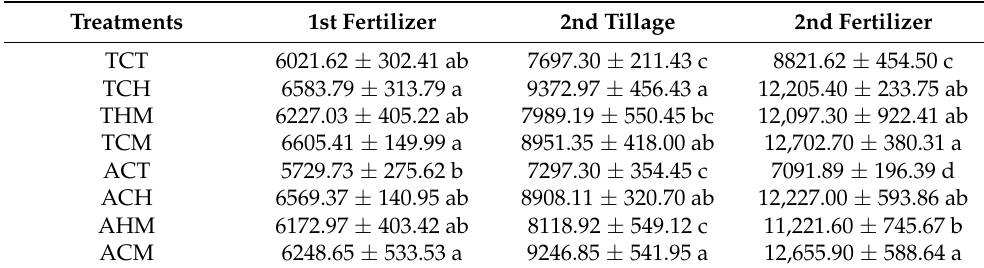
Average ± standard deviation. Different letters in the same column denote significant differences based on Tukey’s test at p < 0.05. TCT, tractor unfertilized control; TCH, tractor chemical fertilizer; THM, tractor horse manure; TCM, tractor chicken manure; ACT, animal unfertilized control; ACH, animal chemical fertilizer; AHM, animal horse manure; ACM, animal chicken manure. Finally, CO 2 emissions accumulated in the soil were higher in tractor tillage compared to animal traction tillage. In addition, the emissions were significantly higher for TCH, TCM and ACM ( p < 0.05), while THM and AHM were the treatments with the lowest CO 2 emissions after the control treatments (Table